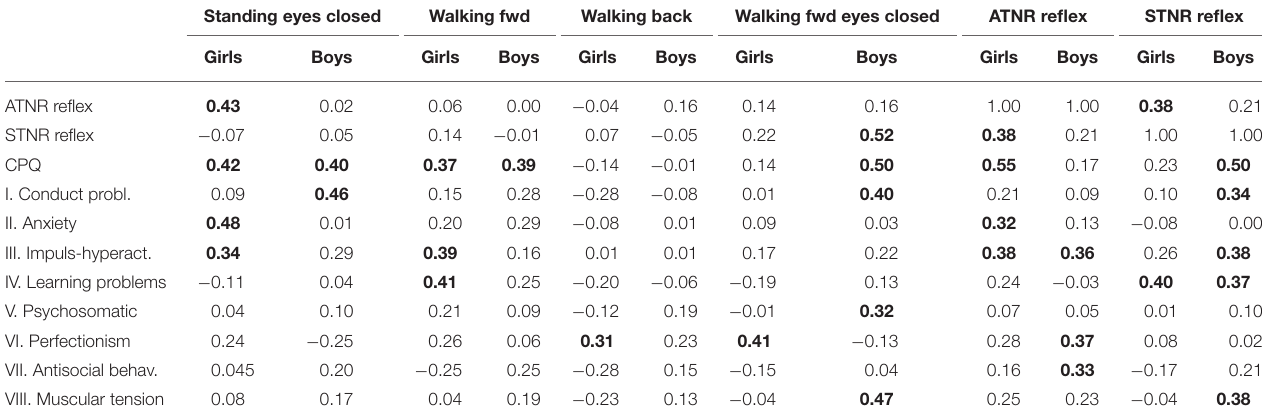
TABLE 1 | Spearman correlations of balancing scores with primitive reflexes and CPQ total score and its subscales in 40 girls and 40 boys with ADHD. Standing eyes closed Walking fwd Walking back Walking fwd eyes closed ATNR reflex STNR reflex